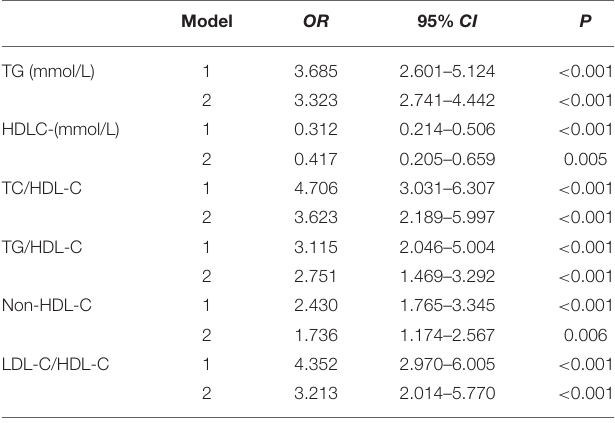
Table 5 and Figure 1 showed the cut-off points of lipid parameters for the prediction of the severity of PAP with their corresponding specificity and sensitivity. The AUC value of TC/HDL-C was larger than that of TG, HDL-C, and non-HDL- C. The AUROC for TC/HDL-C was 0.741 (0.654–0.828),